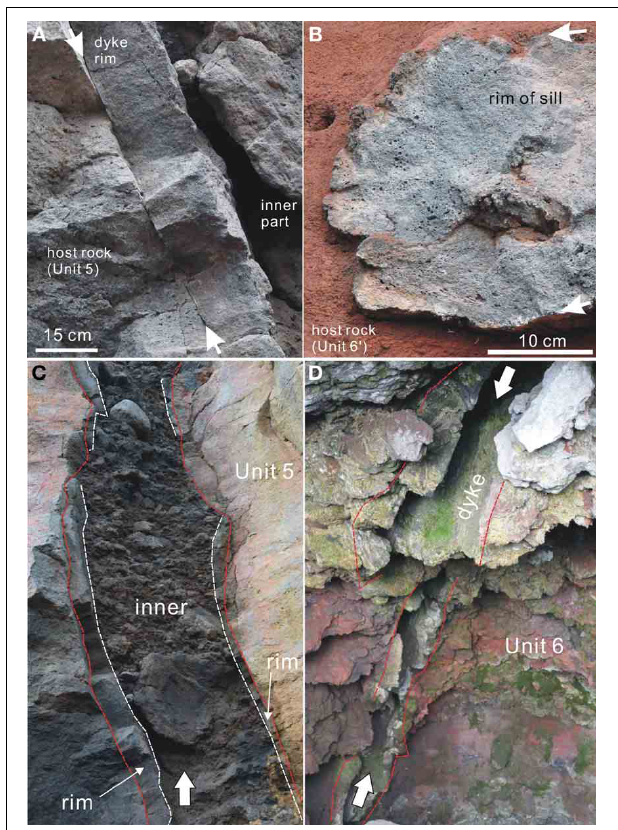
FIGURE 8 | Marginal portion of the feeder in the outcrop A–S (A and B). (A) The dyke margin along the eastern wall of the feeder ∼ 14m below the original ground surface. (B) The eastern tip of the sill. Arrows indicate the intrusive surface of the dyke and sill. Cavities in the center of the feeder dyke (C,D) . White arrows indicate the cavities. (C) The cavity filled with the breccia in the southern wall (outcrop A–S), (D) cavity at the center of the feeder dyke ∼ 20m from the original ground surface (outcrop A–S).